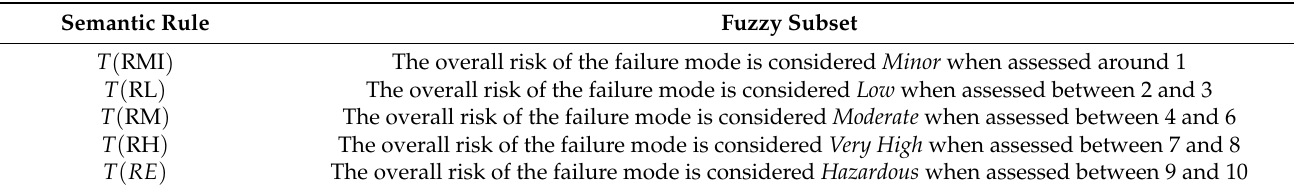
Table 4. Semantic rules for term-set for RPN